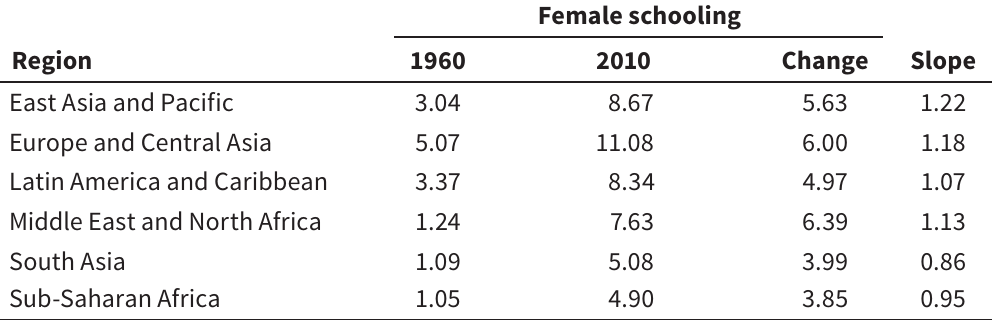
Change in Female Schooling Years.